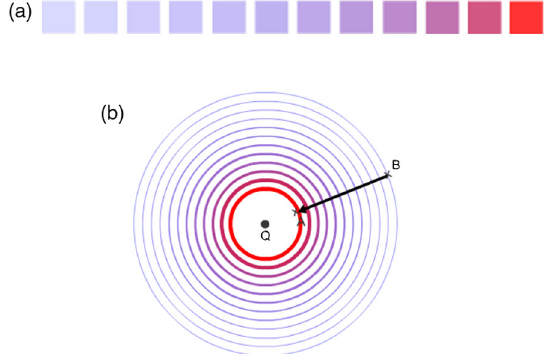
FIG. 3. Example of activating perceptual symbols of “ stronger ” and “ weaker ” via perceptual inference using color saturation and color gradient. (a) More saturated and redder color induces a feeling of being stronger, while a more transparent and bluer color seems weaker. (b) Perceptual symbols representing “ in- creasing magnitude ” activated by a combination of color satu- ration, color gradient, and line thickness, in the context of electric potential